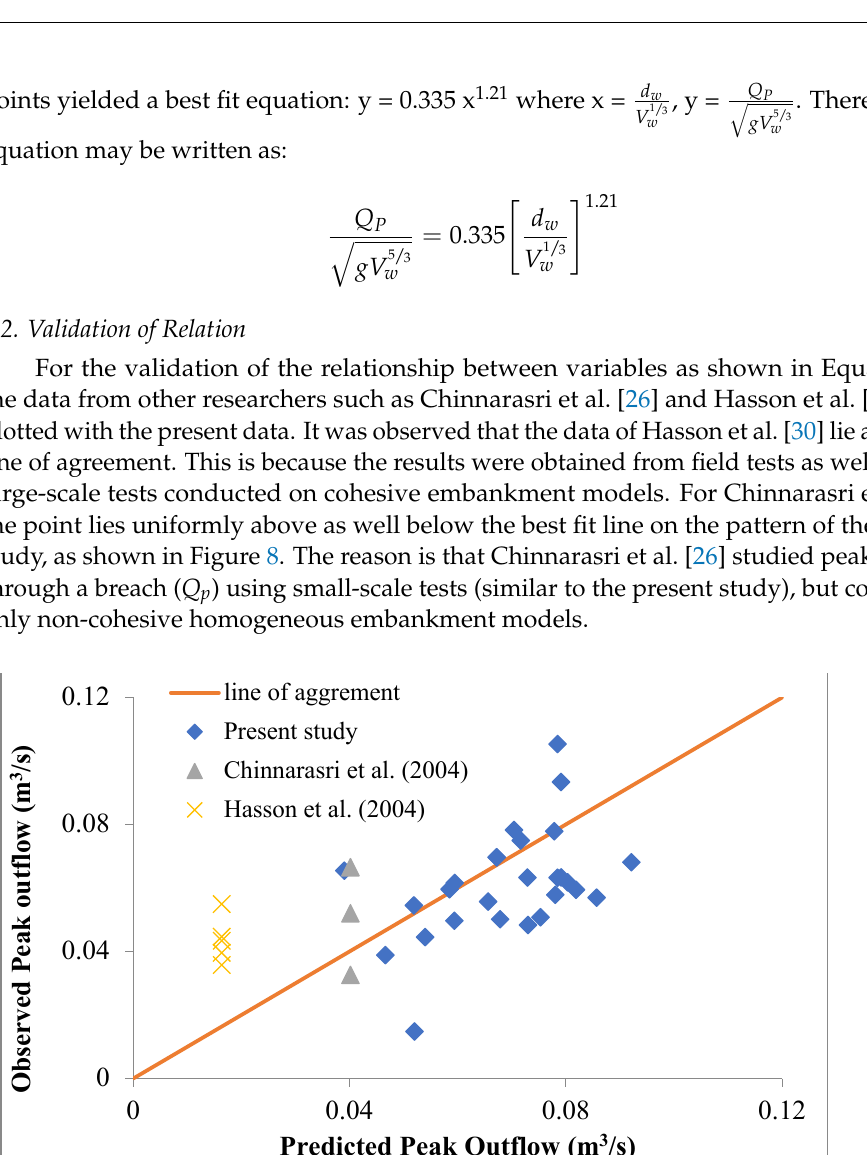
Figure 9. Variation of